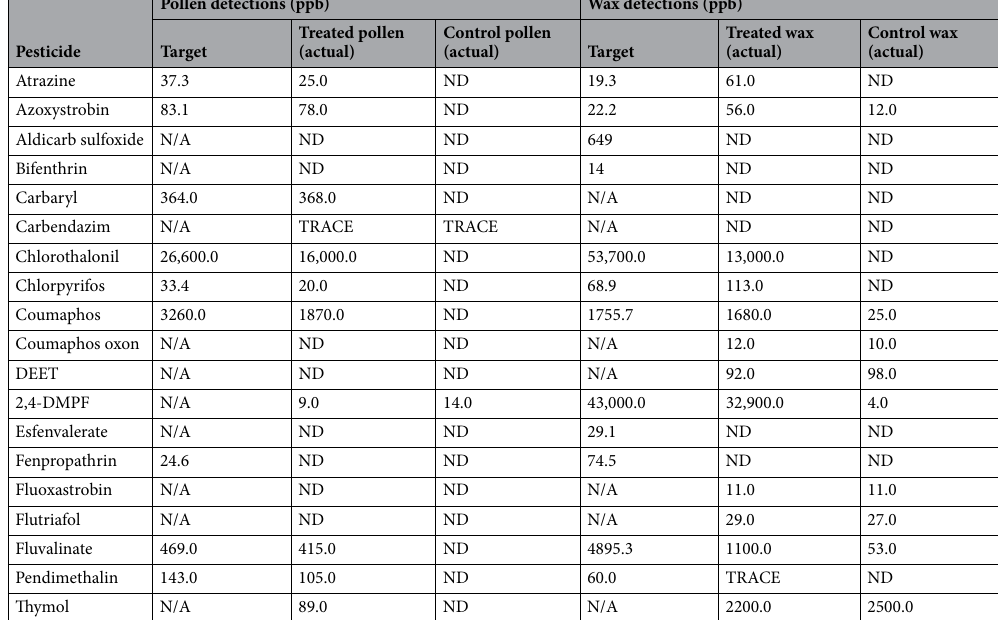
Table 1. Target concentrations for treatments and residue detections in pollen and wax. ND signifies a non- detection. Trace indicates that a compound was detected but was unable to be quantified. 2,4-DMPF and coumaphos oxon are metabolites of the pesticides amitraz and coumaphos,